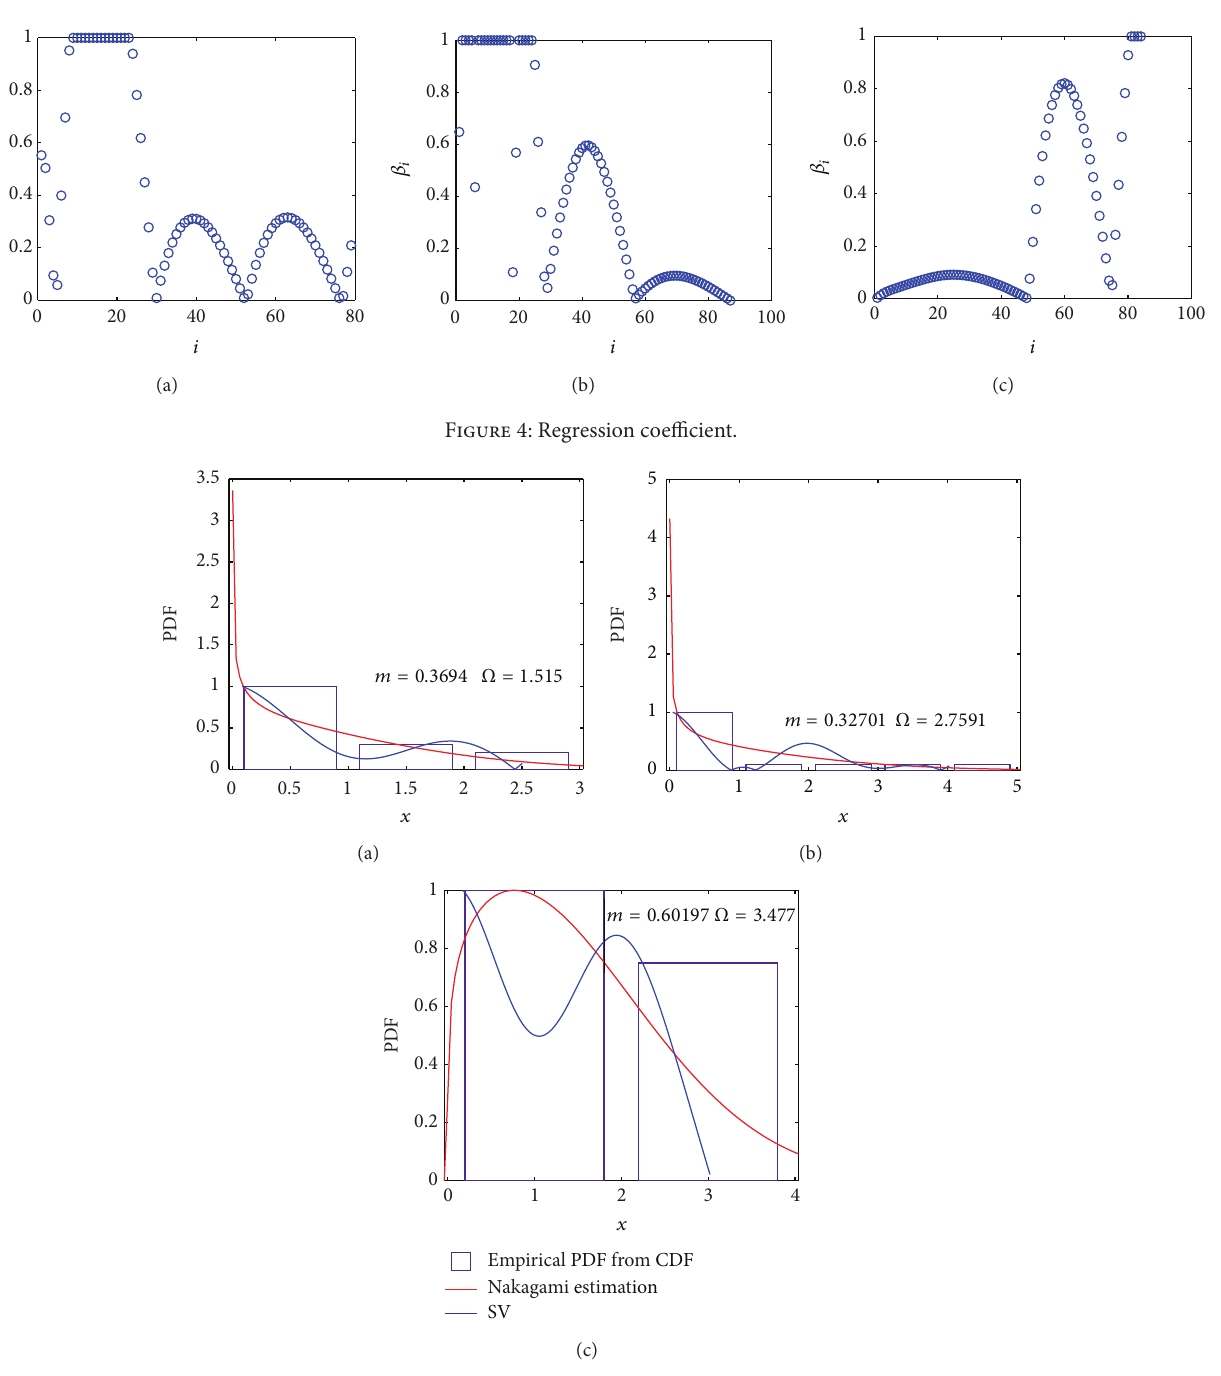
Figure 5: Density estimation comparisons for the RMS delay